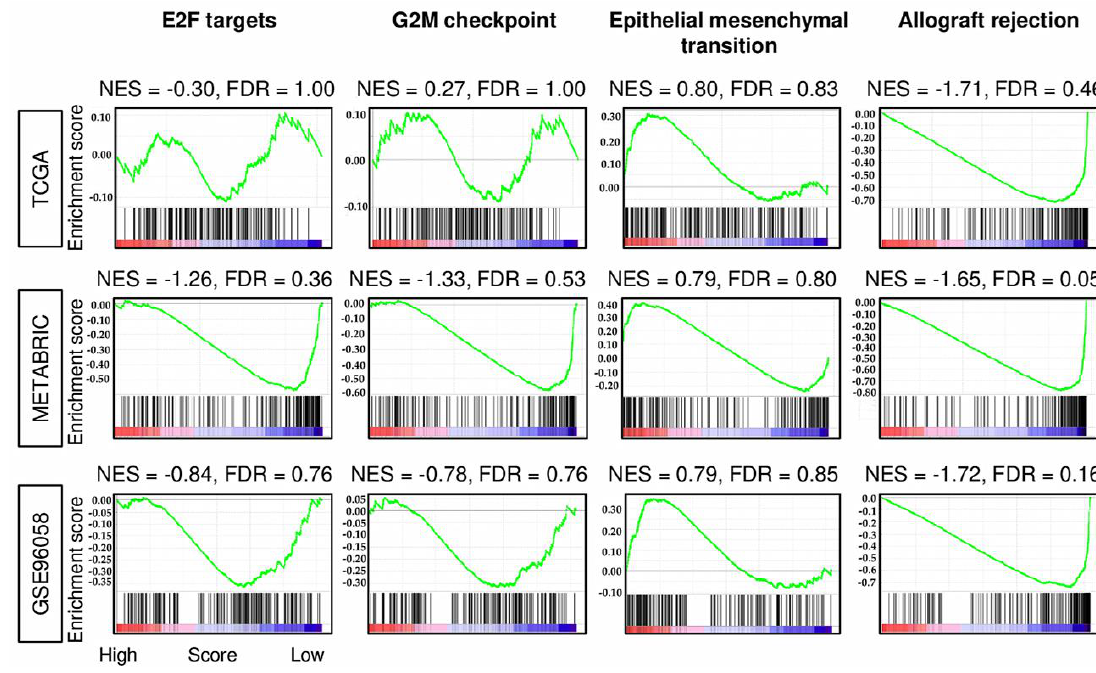
Figure 3. Gene set enrichment analysis (GSEA) of estrogen response early score in ER-positive / HER2-negative breast cancer. GSEA plots of the comparison between low and high estrogen response gene with normalized enrichment score (NES) and false discovery rate (FDR) in the TCGA, METABRIC, and GSE96058 cohorts. FDR < 0.25 was statistically significant in the analysis, as recommended by GSEA